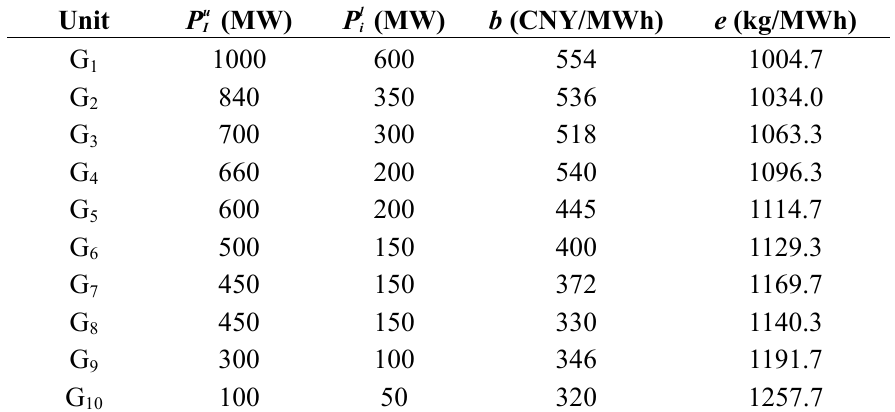
Table 1. Parameters of generators.